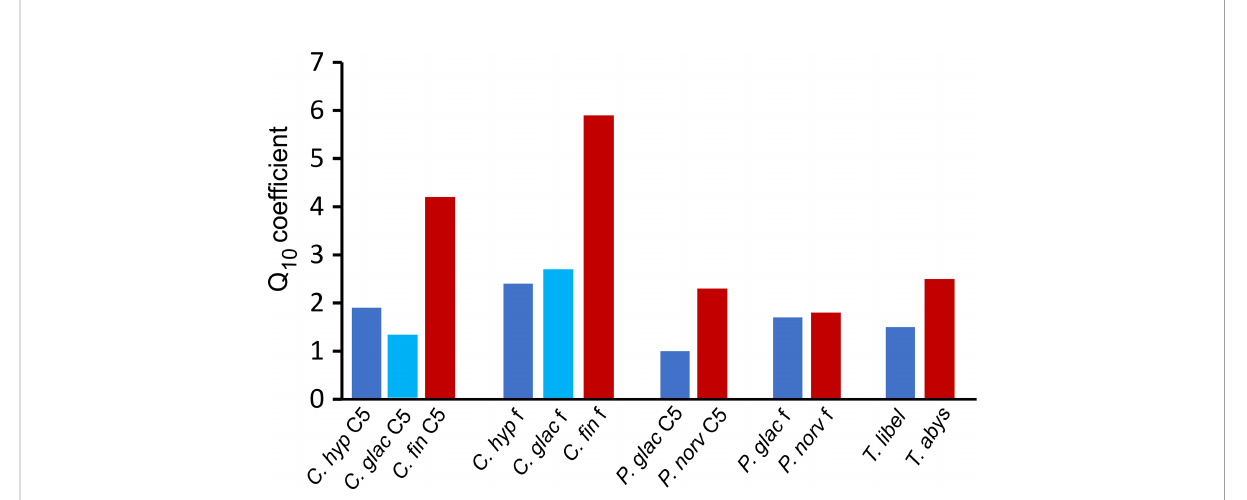
FIGURE 3 Q 10 values of polar-Arctic (blue) versus boreal-Atlantic (red) zooplankton species based on exponential regression of mass-speci fi c respiration rates at different temperatures (0, 4, 6, 8 and 10°C). C. hyp , Calanus hyperboreus ; C. glac , Calanus glacialis ; C. fi n , Calanus fi nmarchicus ; P. glac , Paraeuchaeta glacialis ; P. norv , Paraeuchaeta norvegica ; T. libel : Themisto libellula ; T. abys , Themisto abyssorum ; f, adult female; C5, copepodite stage